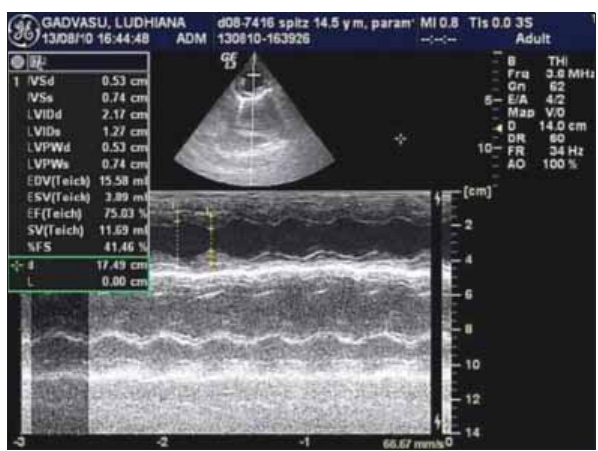
Figure-14: Normal left ventricular measurements and normal functioning of the heart.